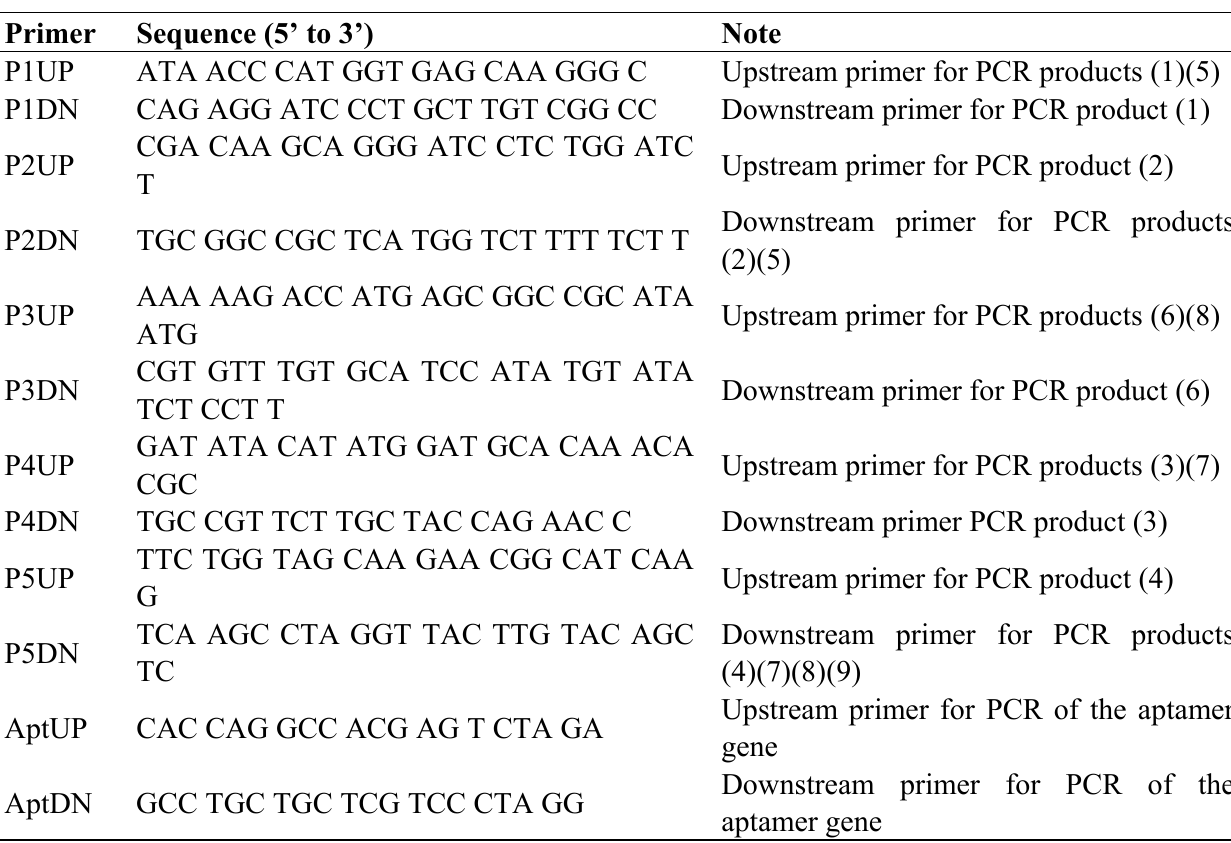
Table 2s. Primers used for PCR amplification (see Figure